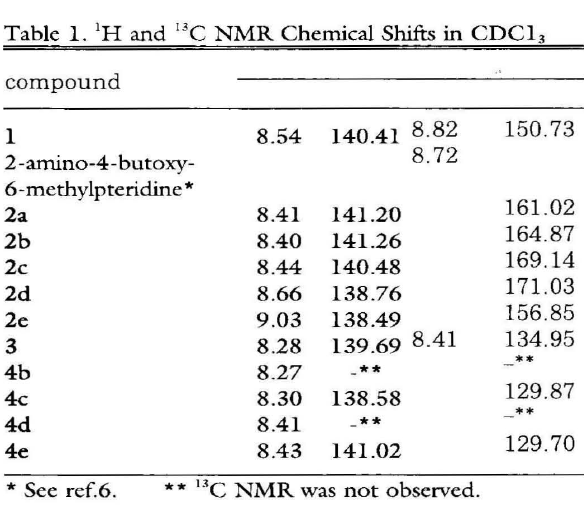
Table 1. IH and I'C NMR Chemical Shifts in CDC1